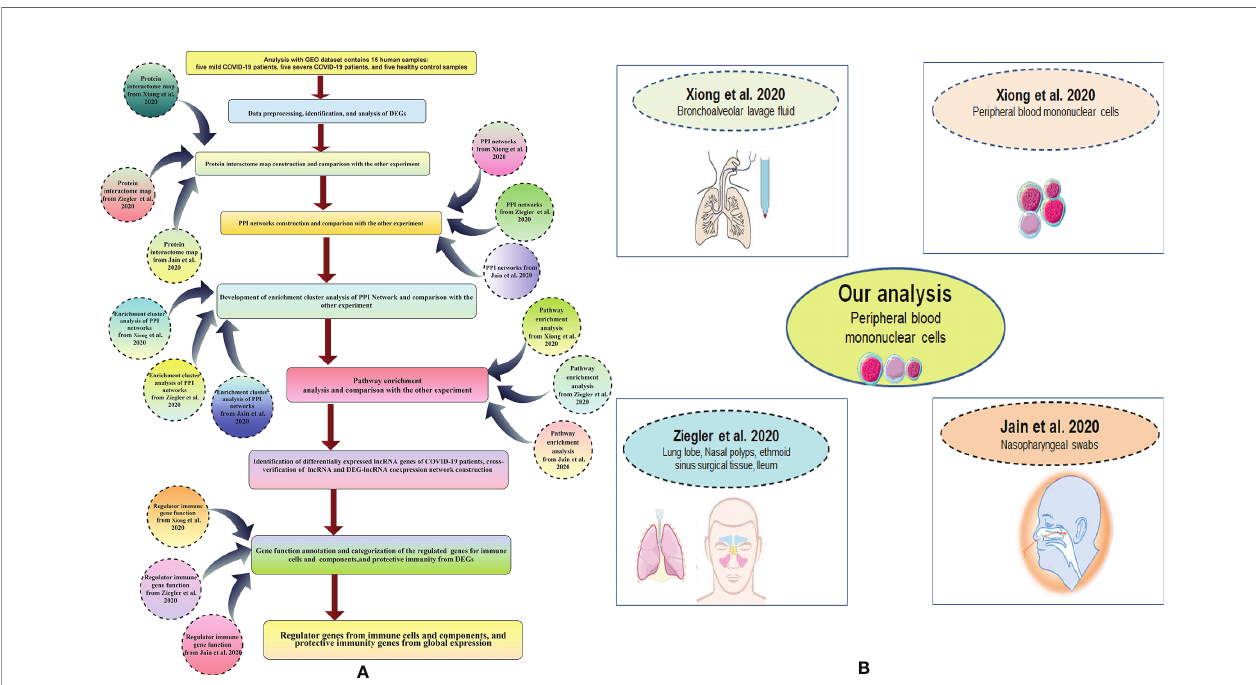
FIGURE 1 | Outline of the work fl ow and diverse sample types of our entire study. (A) A brief work fl ow of our bioinformatics study. (B) Different diverse sample types of our complete